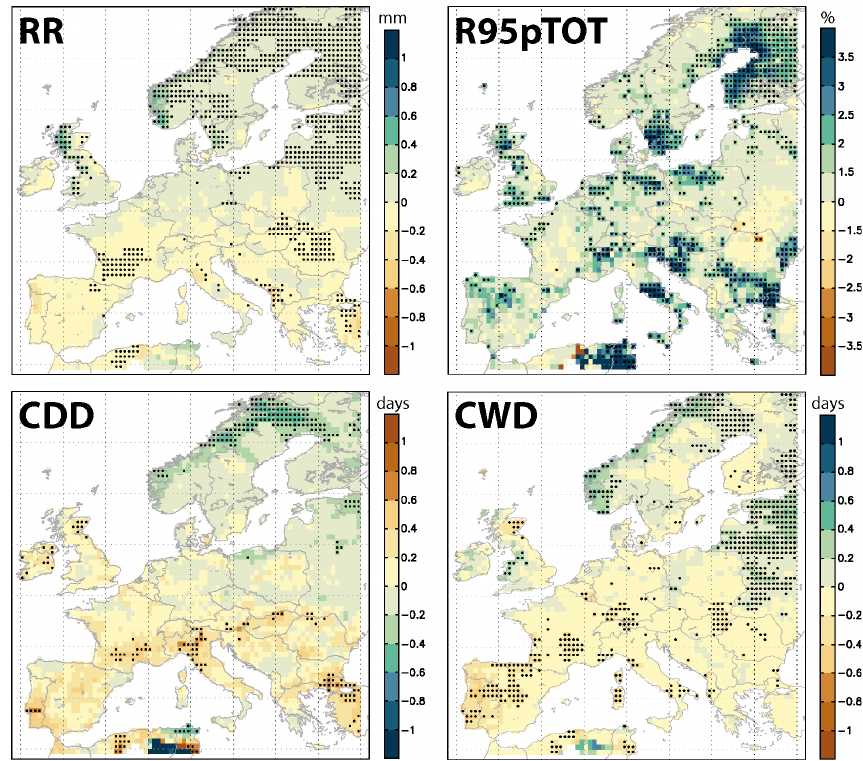
Fig. 2. Trend maps of RR, R95pTOT, CDD and CWD in winter. Shadings represent the Sen’s slope per decade (bluish (brownish) colours mean wetter (drier) conditions). The black dots correspond to those points where the trends are statistically significant at 5% significance level (Z Kendall’s coefficient). Table 2. Correlation coefficients between the leading PCs of mean and extreme precipitation and the teleconnection indices in winter. The variance of each principal component is shown in brackets. Only significant values are shown ( ∗∗ p value < 0.01, ∗ p value <